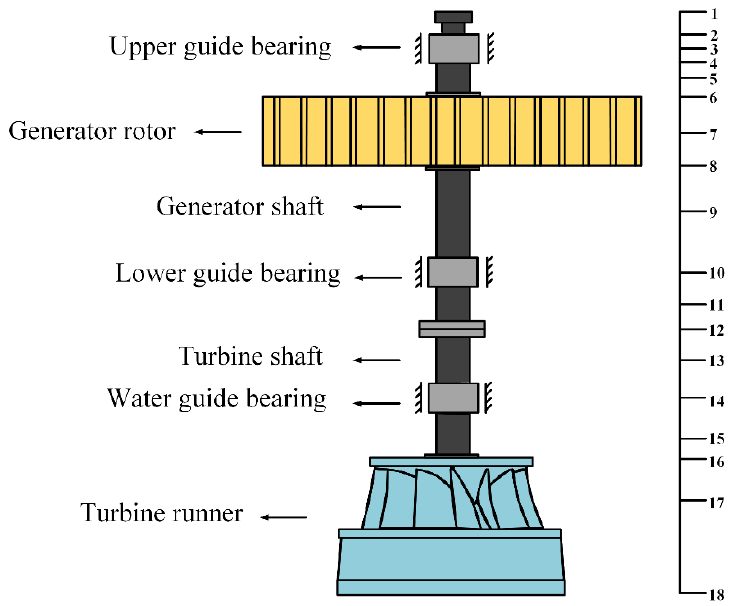
Figure 7. The schematic diagram of the HGSS. (1) WNIM